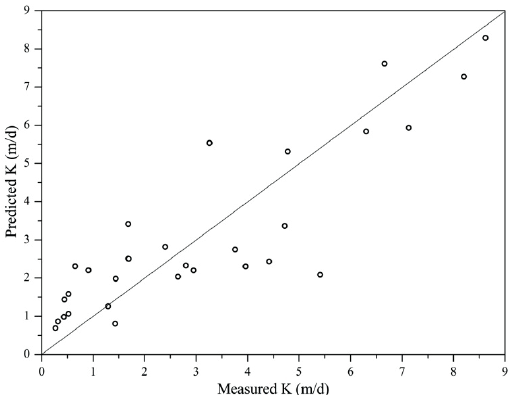
Fig. 3 Plot of measured hydraulic conductivity K m versus predicted values K p using established regression model (straight line represents line of perfect